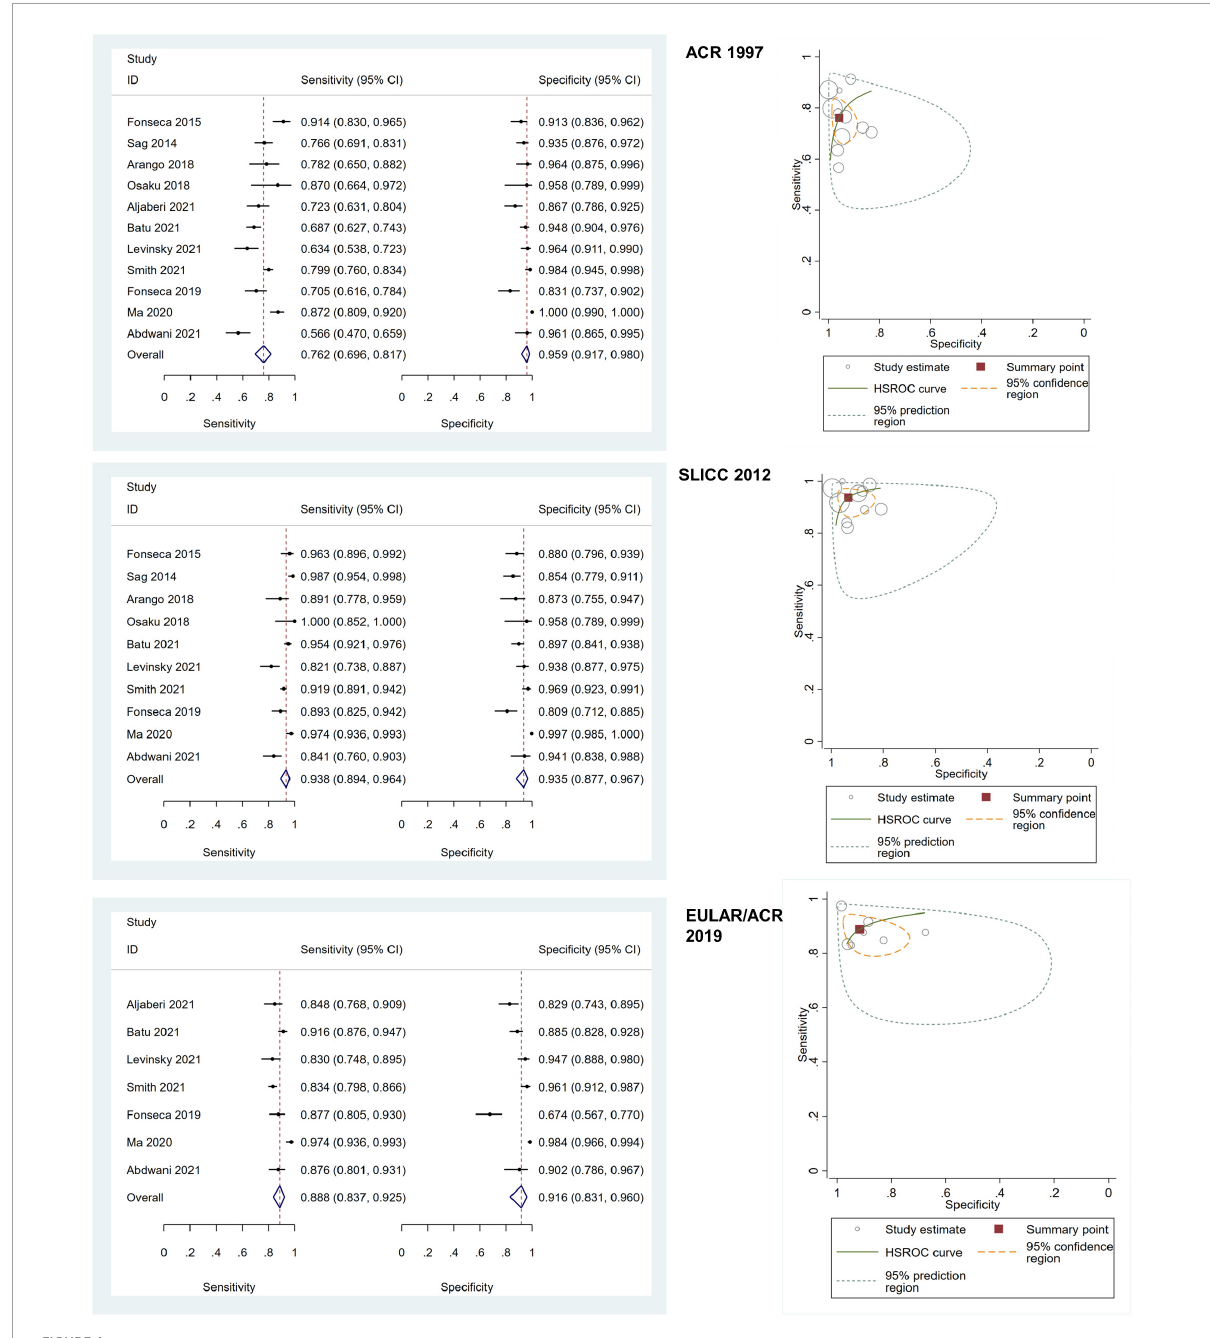
FIGURE4 The forest plots depict the pooled sensitivity and specificity for the included childhood-onset SLE studies and hierarchical summary receiver operating curve of the sensitivity and specificity for the American College of Rheumatology (ACR) 1997, Systemic Lupus International Collaborating Clinics (SLICC) 2012, and European Alliance of Associations for Rheumatology (EULAR)/ACR 2019.